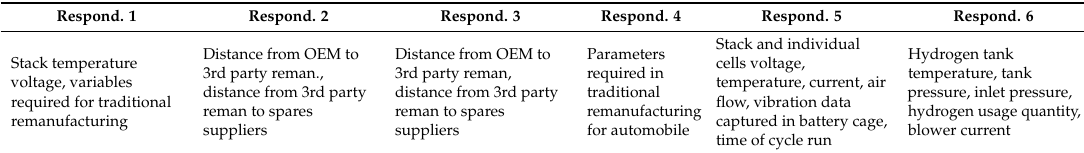
Table 2. Variables needed for fuel-cell